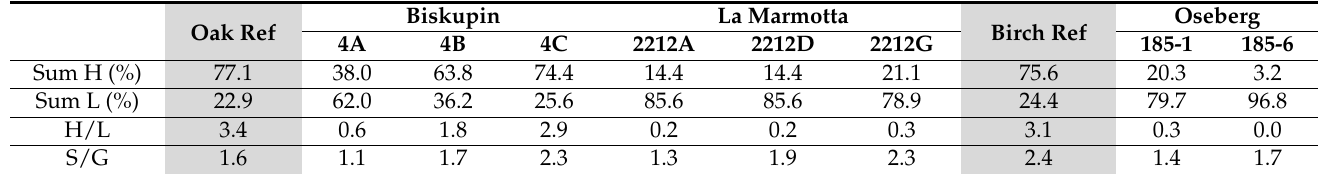
Table 4. Holocellulose (H) and lignin (L) content expressed as percentage values based on chromatographic areas; H/L ratios and syringyl/guaiacyl (S/G) ratios of reference and archaeological wood samples. Biskupin La Marmotta Oseberg Oak